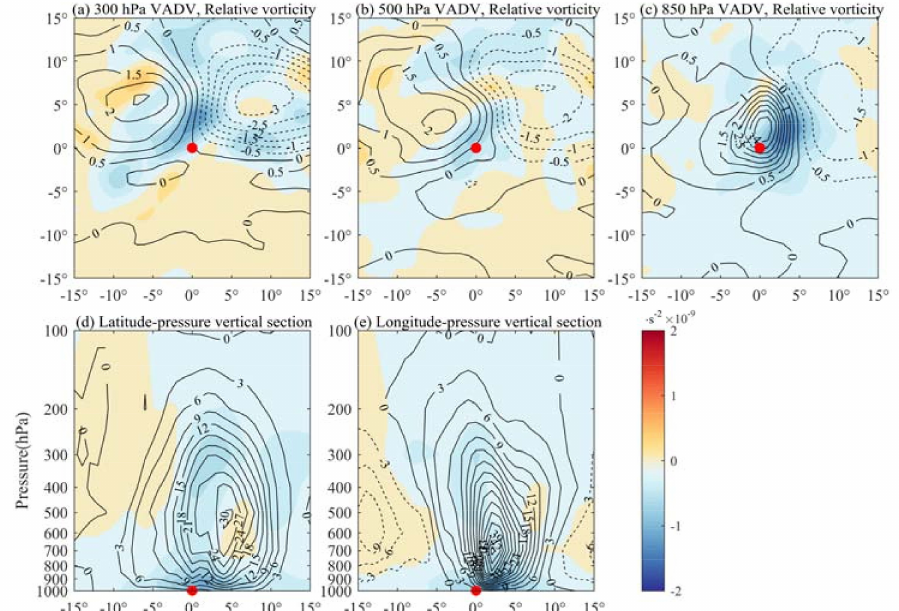
Figure 9. Composite horizontal distribution of relative vorticities (contours, unit: 10 − 5 s − 1 ) and the vorticity advection induced vorticity change (the VADV term, color shading, unit: 10 − 9 s − 2 ) in the cyclone region at the 300 hPa ( a ), 500 hPa ( b ) and 850 hPa ( c ), respectively, under the cyclone centered coordinate, and vertical sections of the vertical velocities (contours, unit: − 1 hPa/s) and the vorticity advection induced vorticity change (the VADV term, color shading, unit: 10 − 9 s − 2 ) along the 0 ◦ latitude ( d ) and 0 ◦ longitude ( e ) in the cyclone centered coordinate, based on the selected cyclones in the Northwest Pacific. The red spot is the center of the extratropical cyclone at the sea